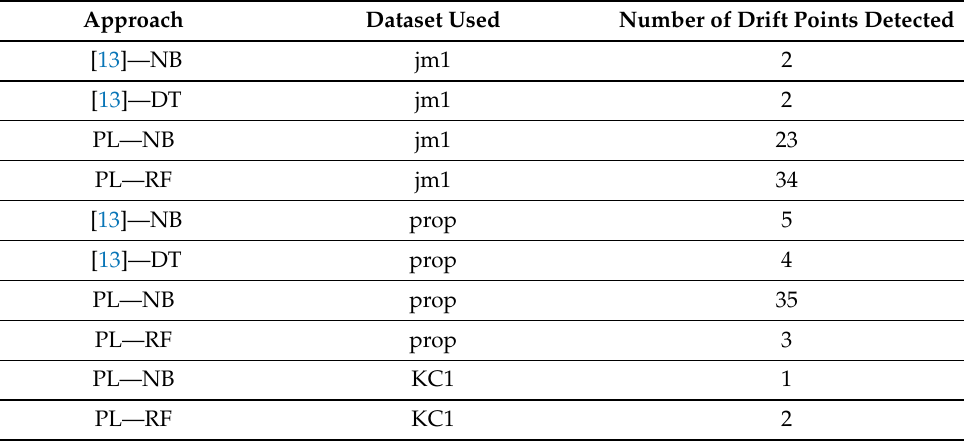
Table 8. Comparative analysis with the existing CD-detection method.